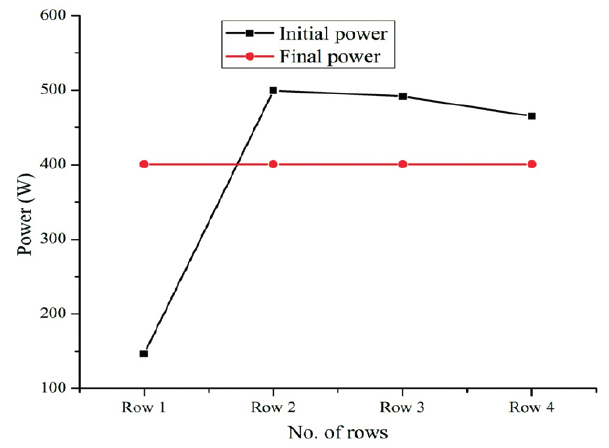
Fig. 11. Comparison of power before and after configuration.